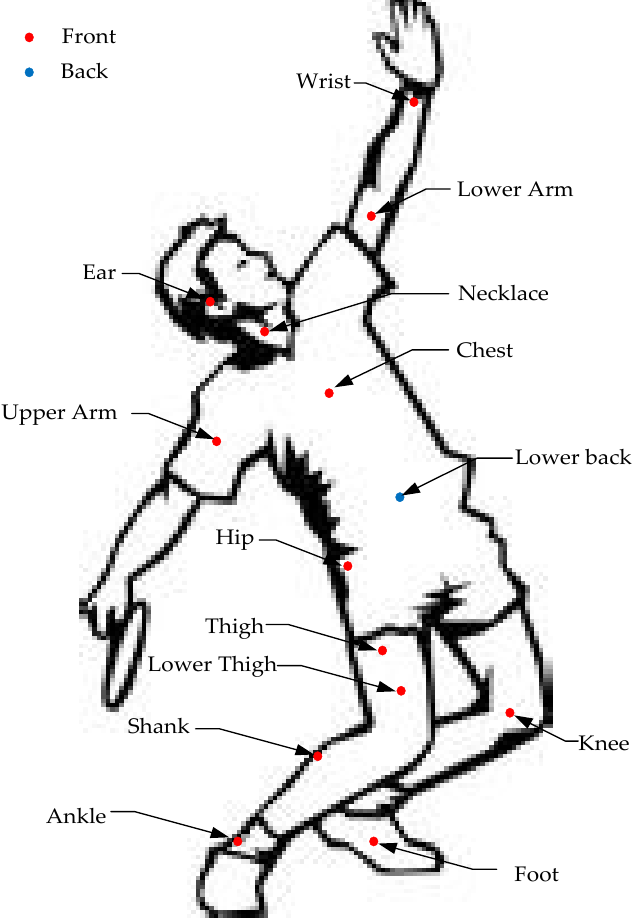
Figure 5. Graphical demonstration of sensor placement.